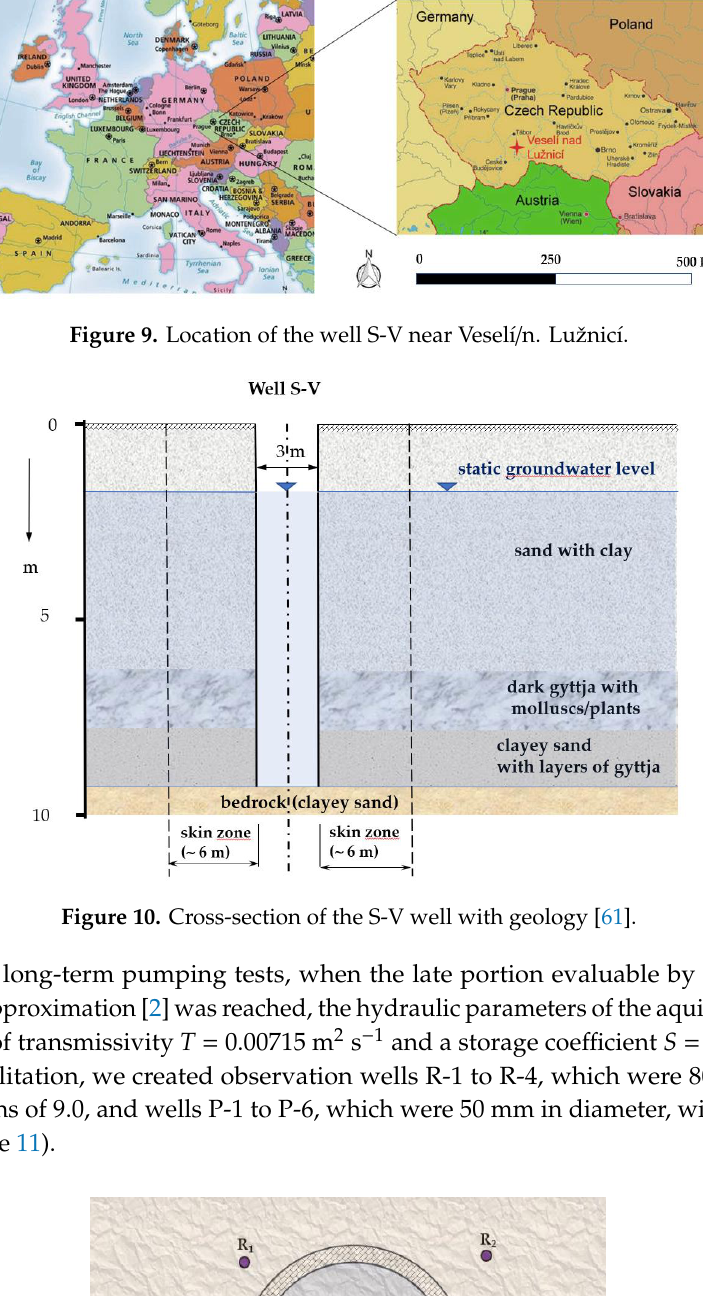
Figure 11. Pumping S-V well with the location of the observation boreholes, P i and R i.